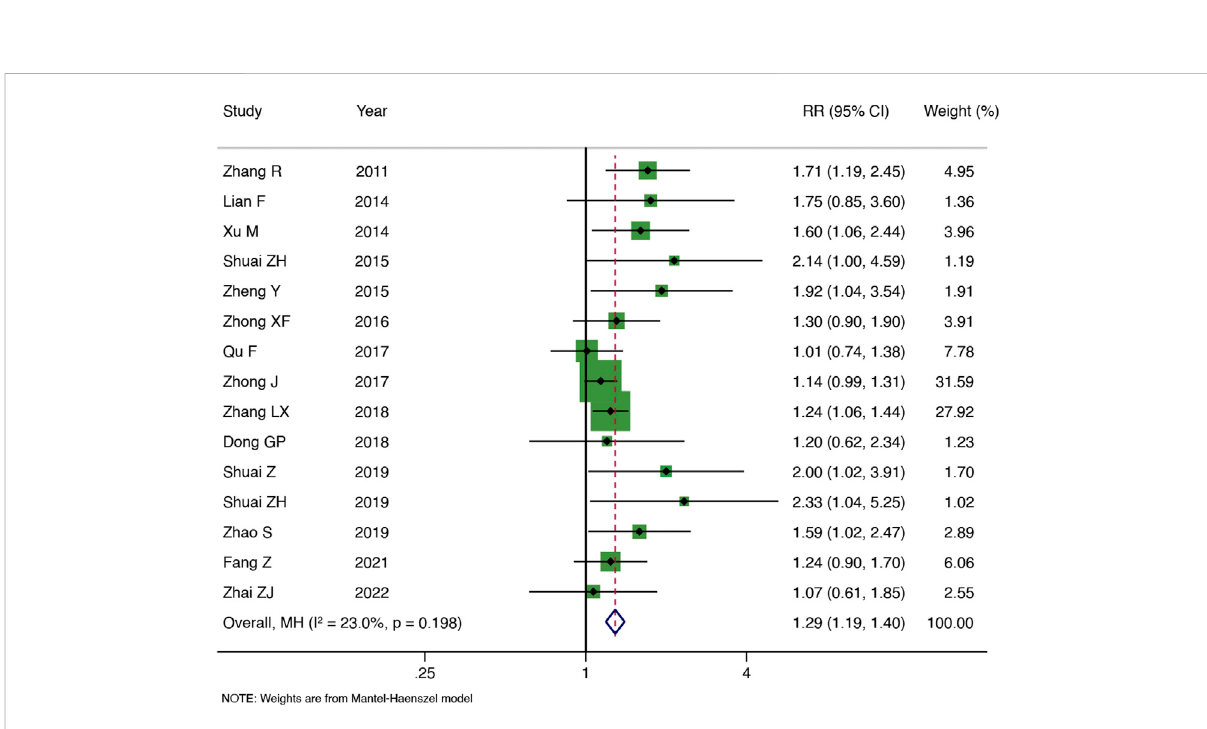
FIGURE 3 Meta-analysis of the clinical pregnancy